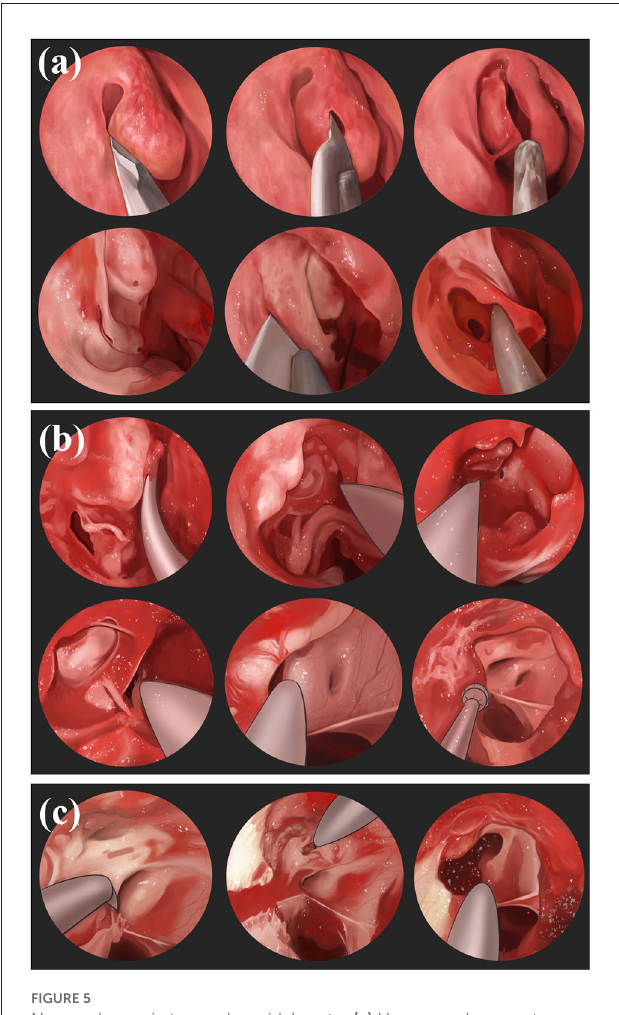
FIGURE5 Nasoendoscopic transsphenoidal route: (a) Use nasendoscopy to pass through the nostril, resects part of the middle turbinatet, exposes the uncinate process and ethmoid bullae of maxillary sinus, and incises the lower 1/3 of the maxillary sinus to expose the maxillary sinus. (b) Resect the ethmoid and sphenoid sinuses, reveal the sphenoid plateau and sellar base, identify the optic nerve carotid crypts as well as the optic nerve bulging. (c) Chisel the medial and superior wall of optic nerve canal and make an incision from medial to lateral.